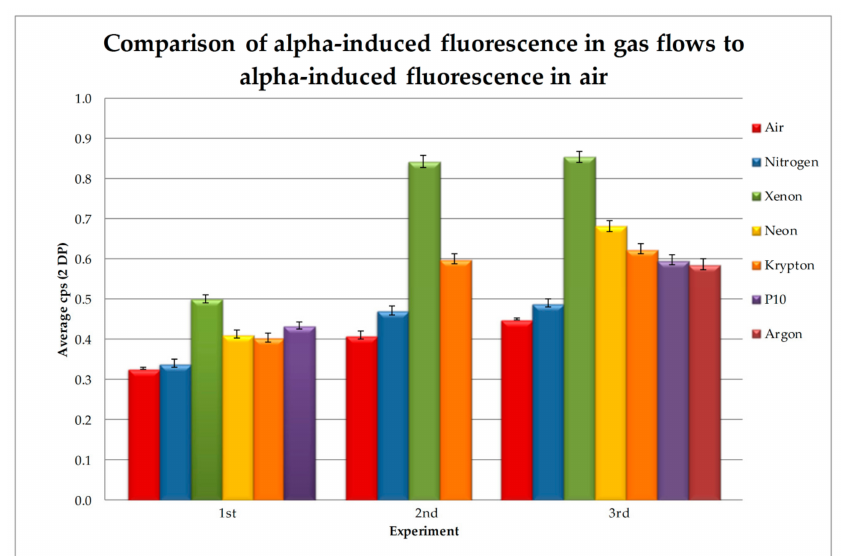
Figure 4. Showing the cps for each of the gas flows in each of the three experiment groups (note: not all gases were tested in the second group due to time constraints) comparing the results of those in the first group reported by Crompton et al. [13] with two following